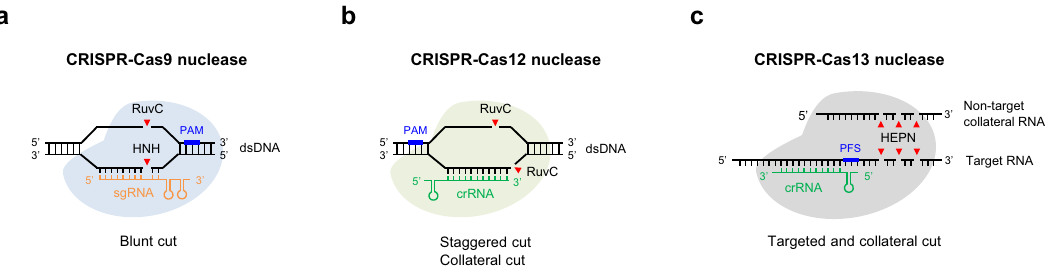
Fig. 1 | Overview of CRISPR-Cas nucleases. a – c CRISPR – Cas9 nucleases and CRISPR-Cas12nucleasesareRNA-guidedDNAeditingtools,whereasCRISPR-Cas13 nucleases have RNA-guided RNA endonuclease activity. Besides targeted cutting, CRISPR-Cas12/13nucleasesalsohavecollateralcuttingactivityonnon-targetDNA/